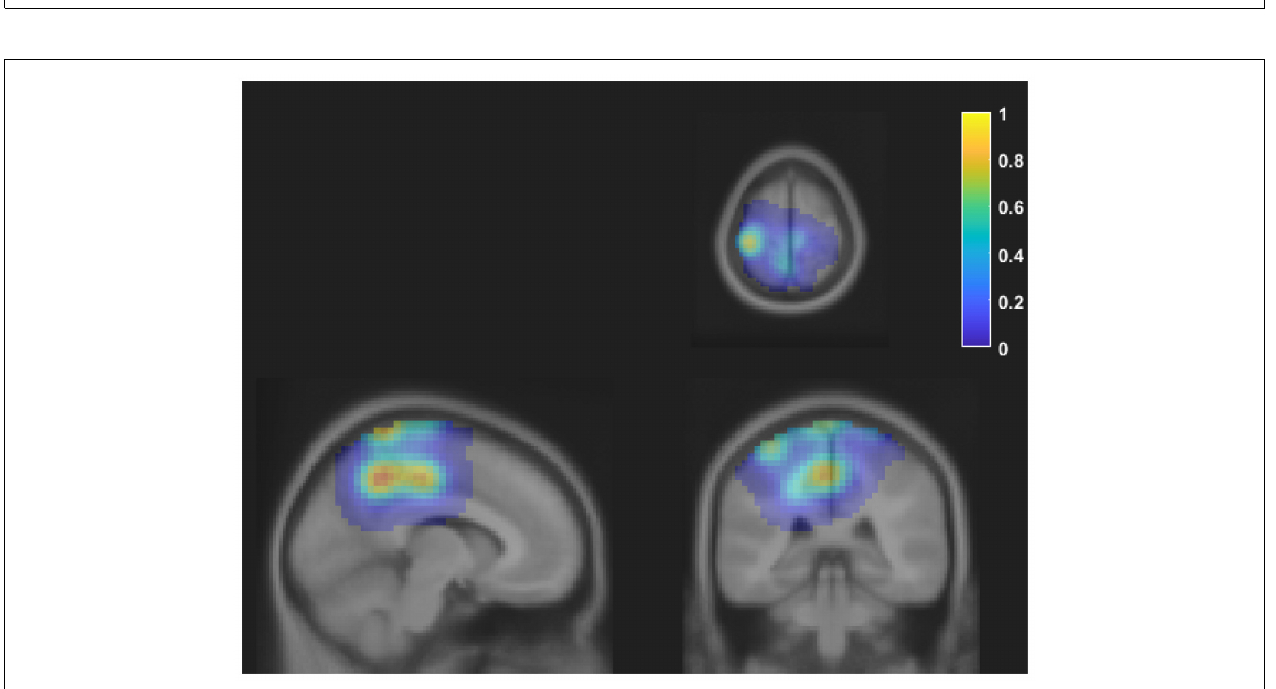
FIGURE 5 | The density of the current dipoles corresponding to each independent component of the cluster. The values were normalized to the maximum value. The cluster includes 21 independent components from six subjects. The mean MNI coordinate was [ − 9 − 35 64], and the standard deviation was [16 14 16]. Each image is shown on axial, sagittal, and coronal planes. Estimated locations of each dipole were the paracentral lobule, postcentral gyrus, and precuneus. MNI, Montreal Neurological